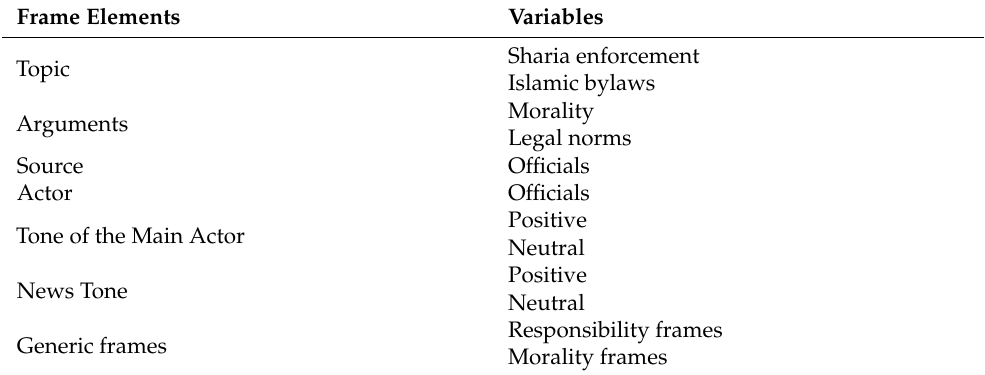
Table 2. The Sharia codification